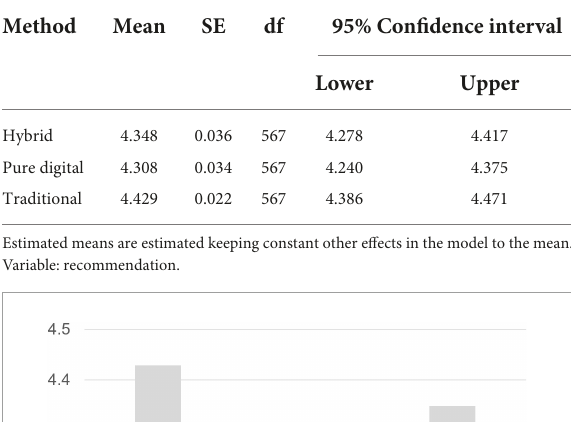
Despite the changed training methodologies, the actual content changed little; accordingly, the training program’s perceived value (valence) may not have changed. However, a statistically significant difference was found in the same dimension, in